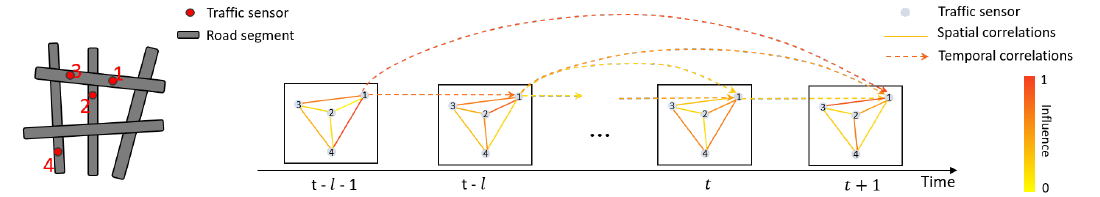
Figure 1. The topological structure of the road network and complex spatial-temporal correlations between sensors.